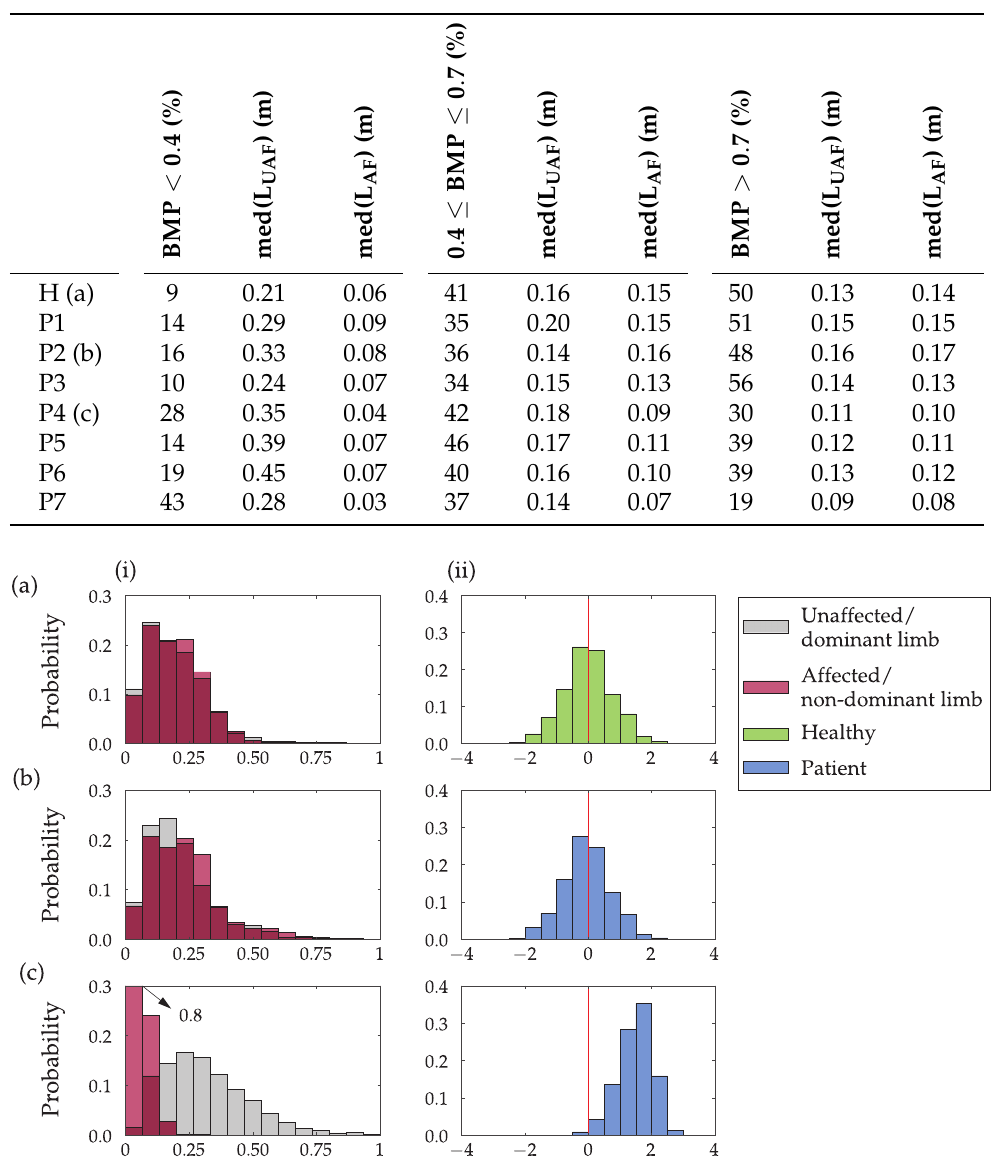
Table 3. Proportion of bimanual and unimanual movements (%) based on BMP and the median movement lengths of the unaffected (dominant) limb and the affected (non-dominant) limb expressed in meters.